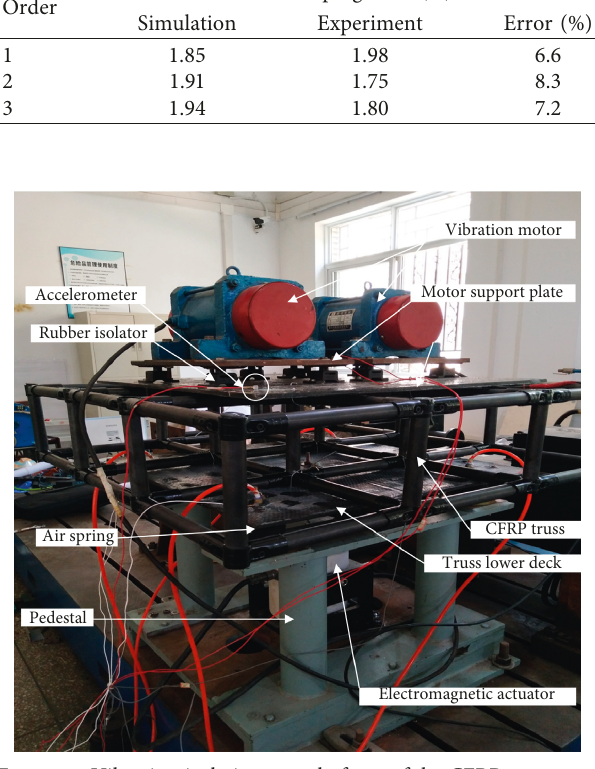
Figure 7: Vibration isolation test platform of the CFRP truss-type floating